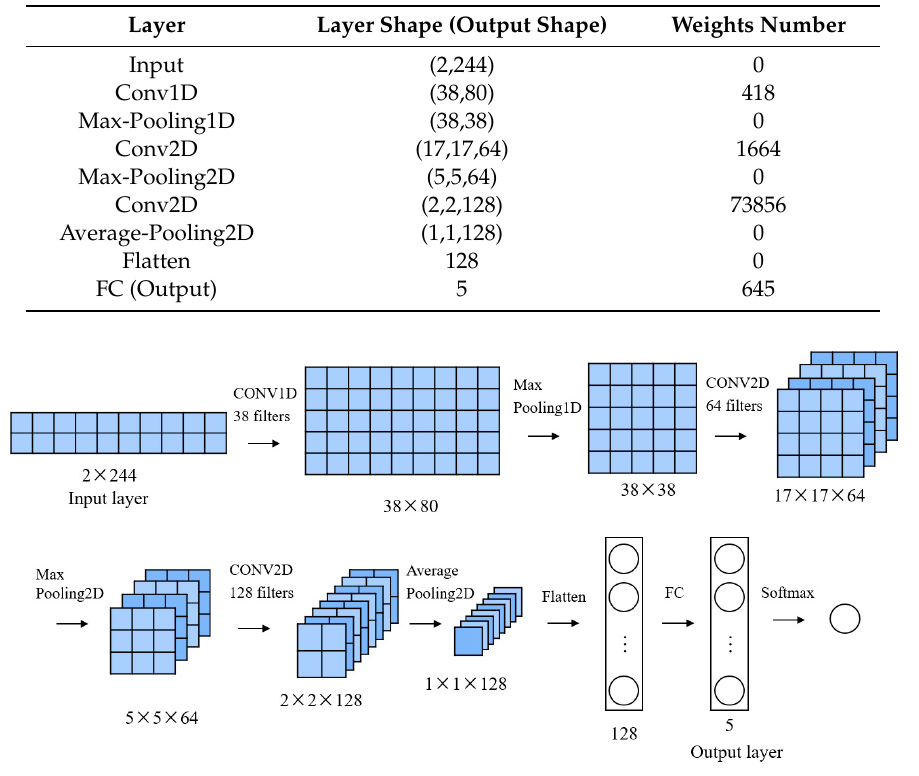
Table 2. The layer shape and weights number of CNN.